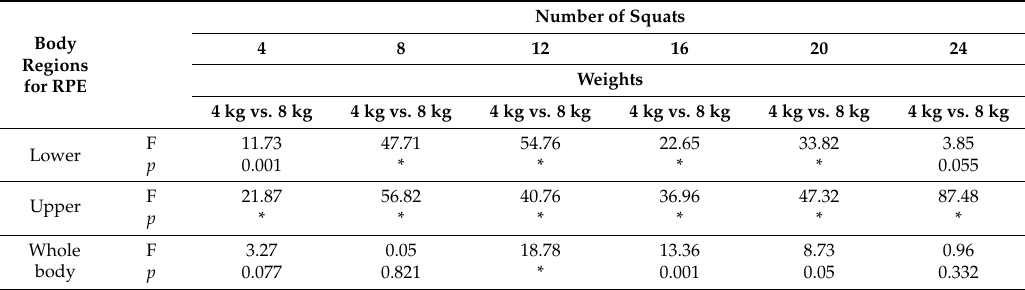
Table 1. ANOVA results of 4 kg and 8 kg squat lifting for three regions of perceived exertions. Rating of Perceived Exertions